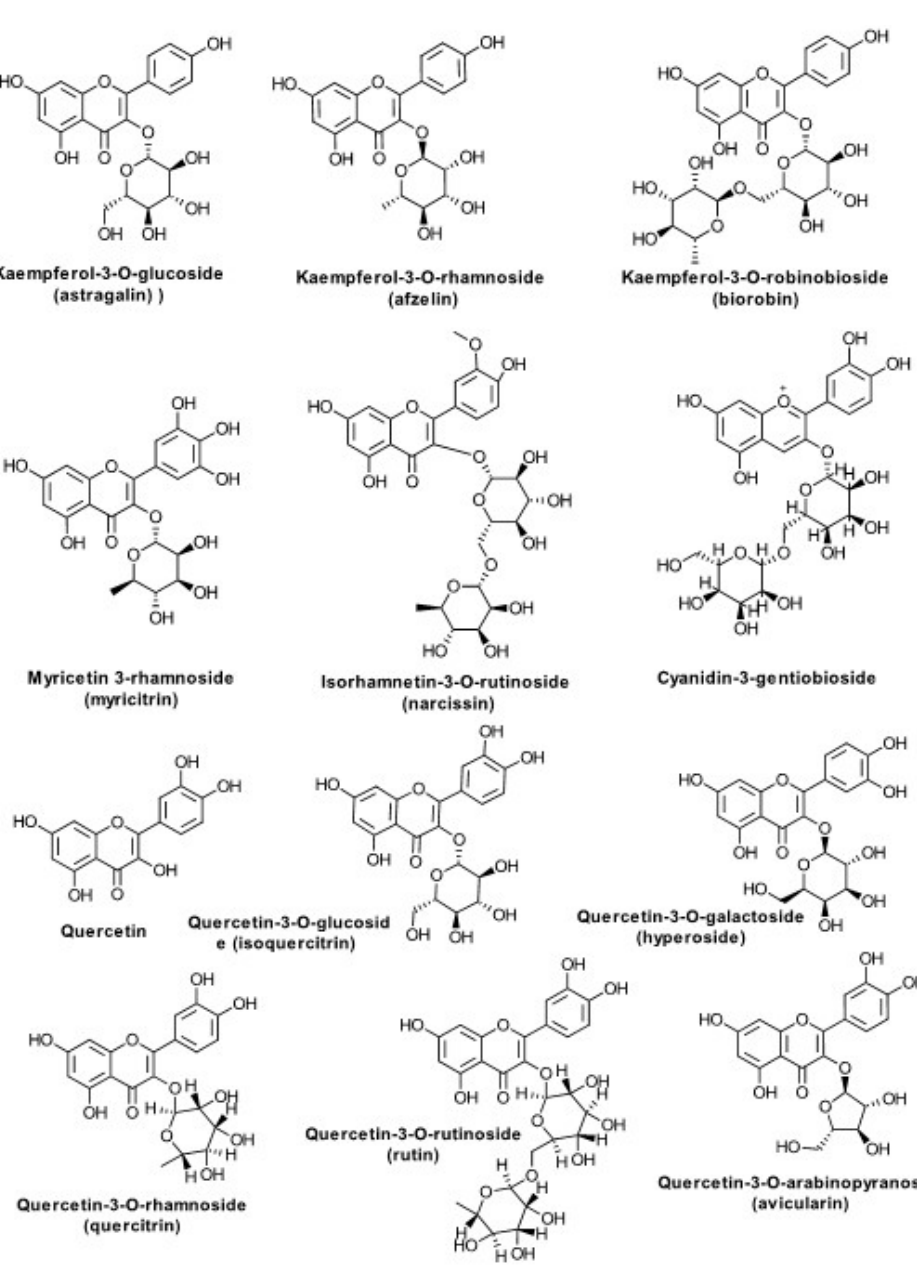
Figure 3. Representative flavonoids from S. virgaurea L.